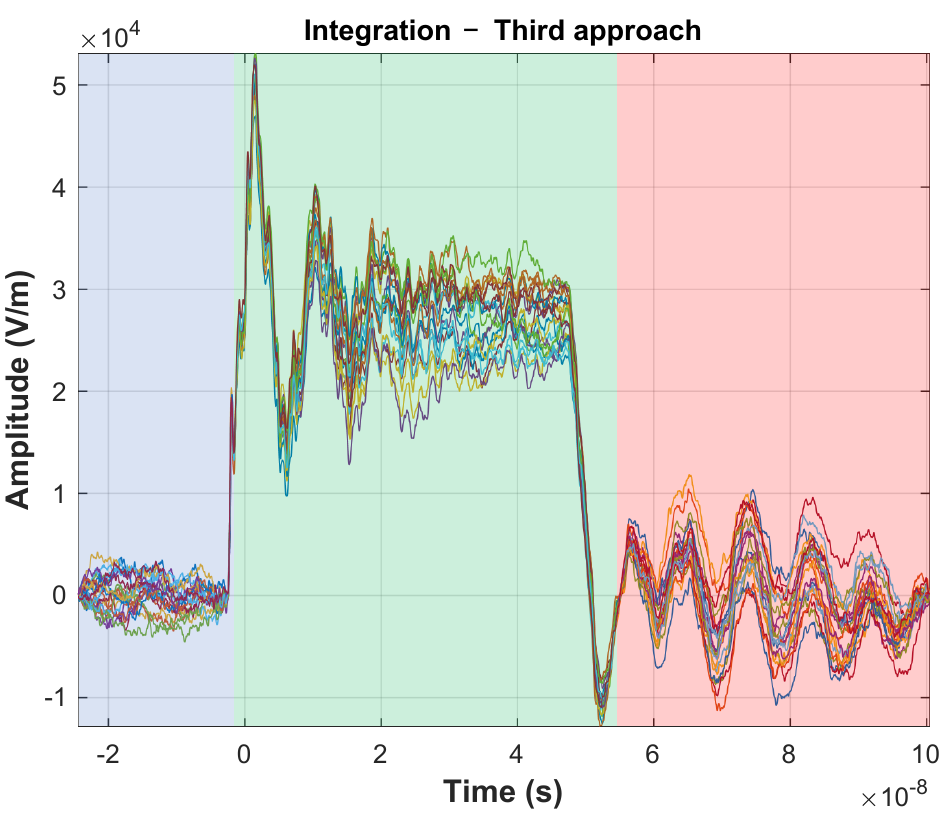
Figure 8. Integrated signal with mean value computed and subtracted from respective portions of signal (colored regions in the plot).